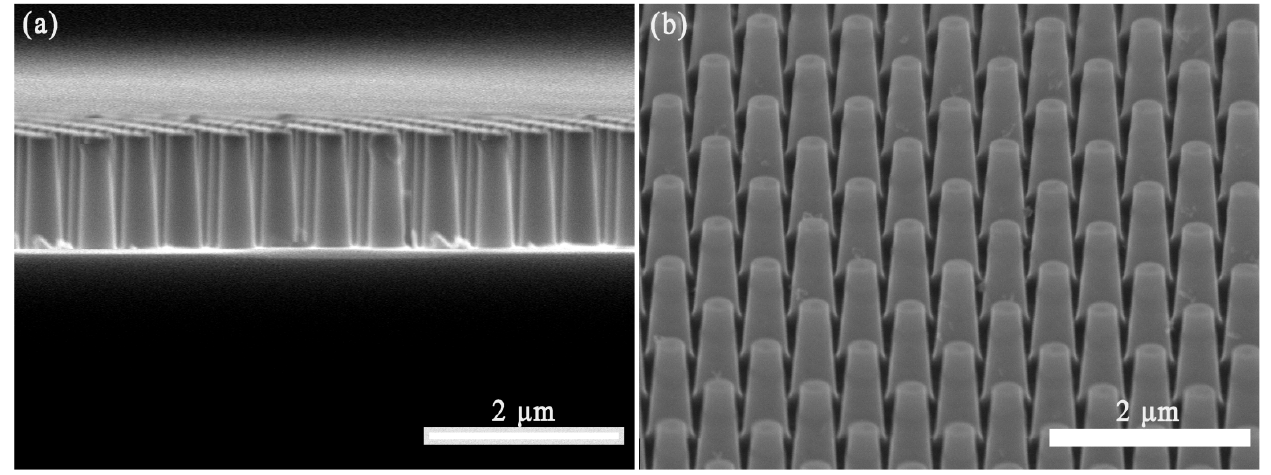
Figure 2. ( a ) Cross section and ( b ) top view SEM images of Si NTCAs.